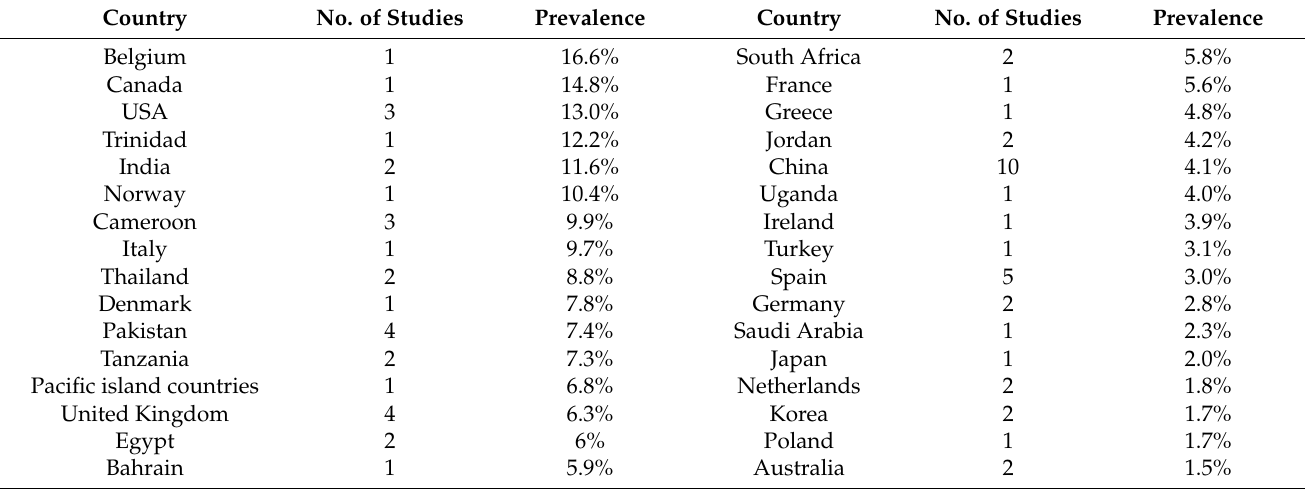
Table 1. Prevalence of diabetic foot ulcers in different countries in the population of patients with DM2 followed at the hospital level and in public health study centers. Source: Pengzi Zhang et al., No. of 2017 [12].